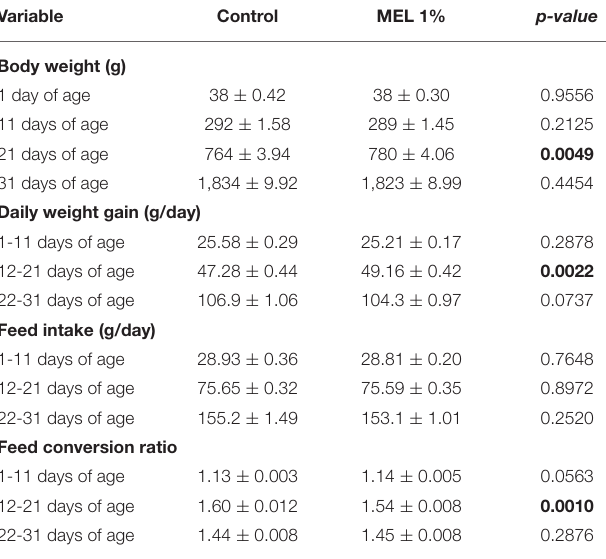
TABLE 8 | Effects of MEL extract supplementation on zootechnical performance of chickens reared under suboptimal starting conditions.